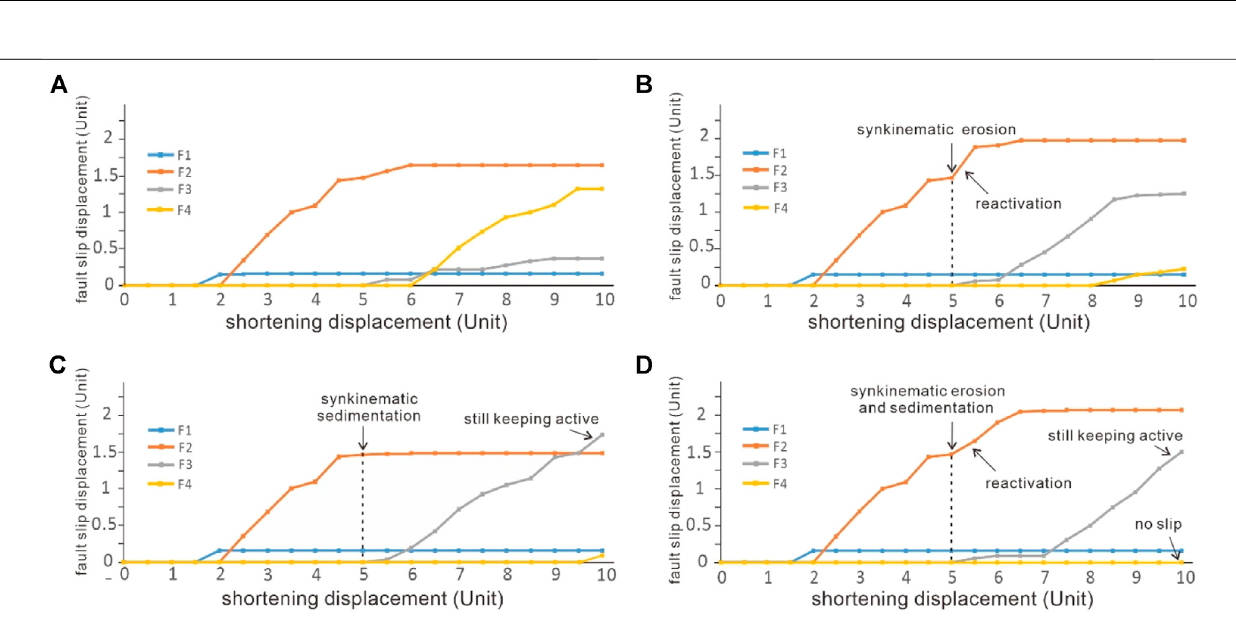
Frontiers in Earth Science |